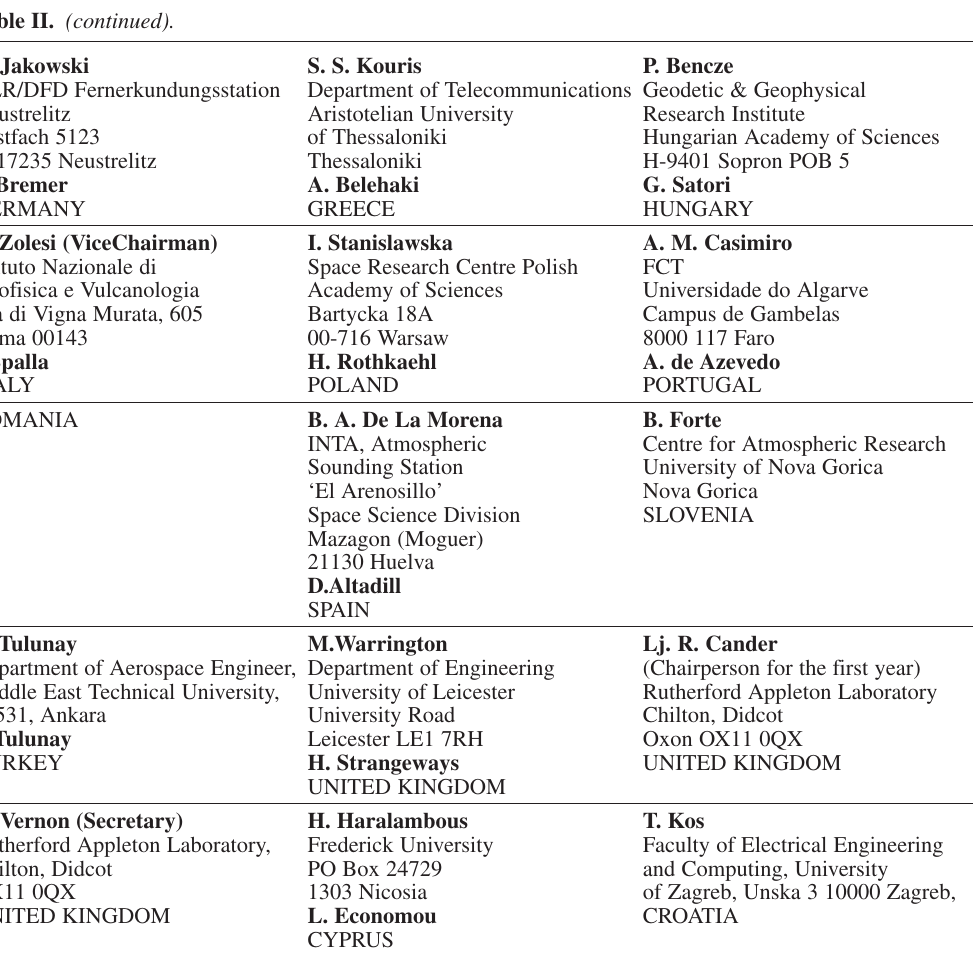
Table II. (continued).